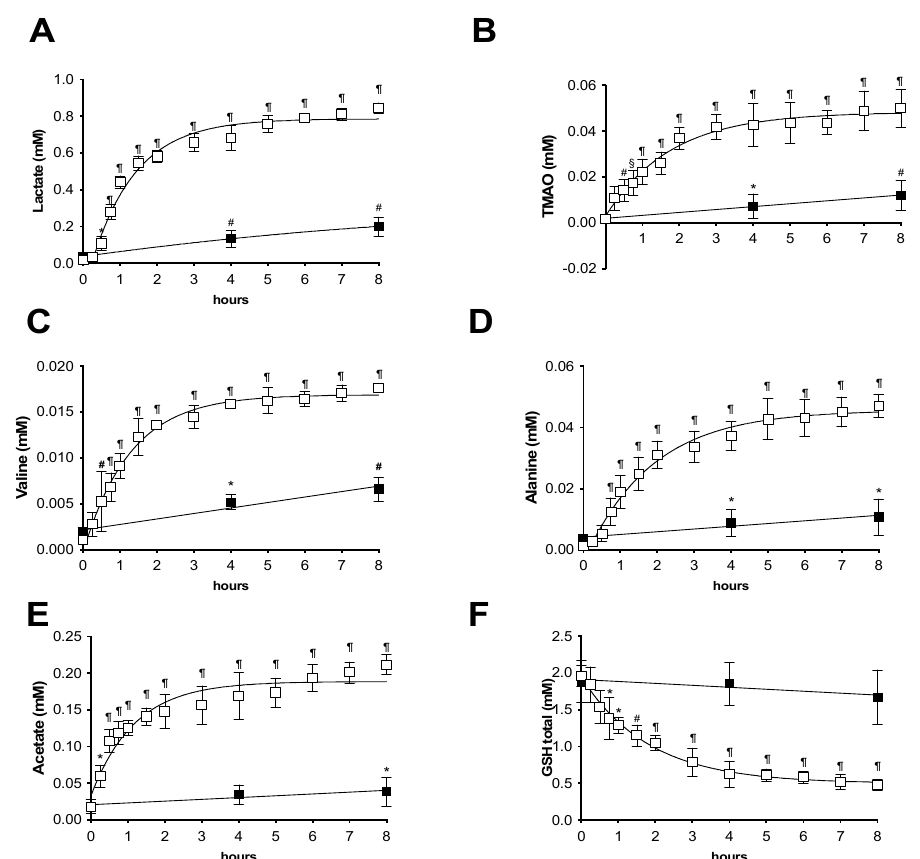
Figure 3. 1 H-NMR metabolite concentration (mM) during hypothermic kidney perfusion (HMP, empty symbols) and static cold storage (SCS, full symbols). The rate (mM/h) of the fitted trend resulted as follows: ( A ) lactate (HMP: K = 0.83, R 2 = 0.98; SCS: K = 0.02, R 2 = 0.97), ( B ) trimethylamine N-oxide (TMAO; HMP: K = 0.57, R 2 = 0.98; SCS: K = 0.001, R 2 = 0.99), ( C ) valine (HMP: K = 0.78, R 2 = 0.99; SCS: K = 0.0005, R 2 = 0.95), ( D ) alanine (HMP: K = 0.55, R 2 = 0.98; SCS: K = 0.001, R 2 = 0.90), ( E ) acetate (HMP: K = 0.85, R 2 = 0.93; SCS: K = 0.002, R 2 = 0.88), and ( F ) total glutathione (GSH; HMP: K = 0.55, R 2 = 0.99; SCS: K = − 0.026, R 2 = 0.85). The results are expressed as mean ± SD. Significant differences: * p < 0.05; # p < 0.01, § p < 0.001, and ¶ p < 0.0001.